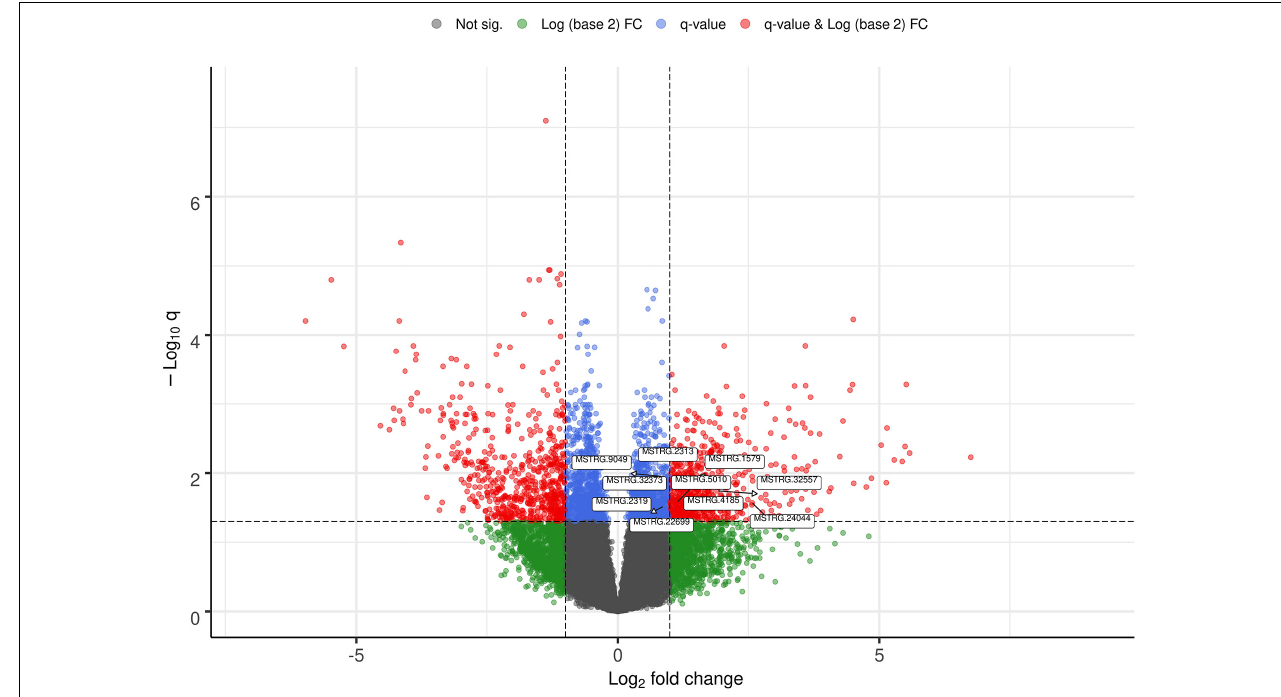
FIGURE 3 | Volcano plot showing the differentially expressed (DE) genes with the selected target lncRNA loci for co-expression analysis.